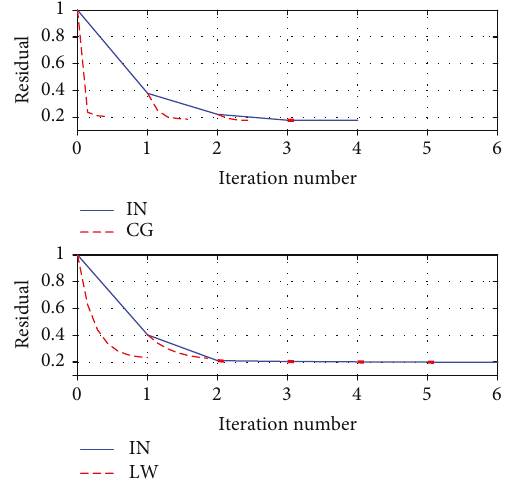
Figure 12: Behaviour of the normalized data residuals for the conjugate gradient-based (top, p = 1 5 ) and Landweber-based opt = 1 3 ) methods versus the iteration number. Residuals (bottom, p opt in the outer inexact Newton (IN) iterations and in the inner conjugate gradient (CG) and Landweber (LW) loops are reported. Inhomogeneous cylinder with SNR = 30 dB